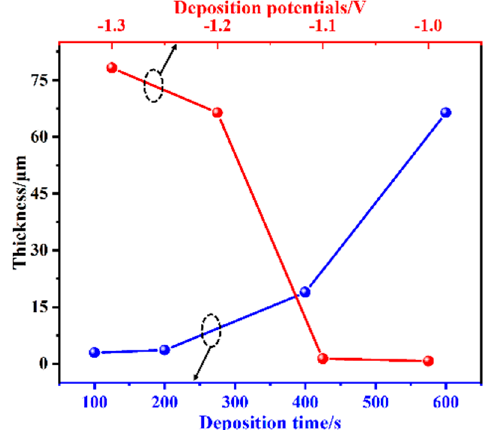
Figure 5. Influences of deposition time (blue) and potential (red) on the thickness of E-MTES films .